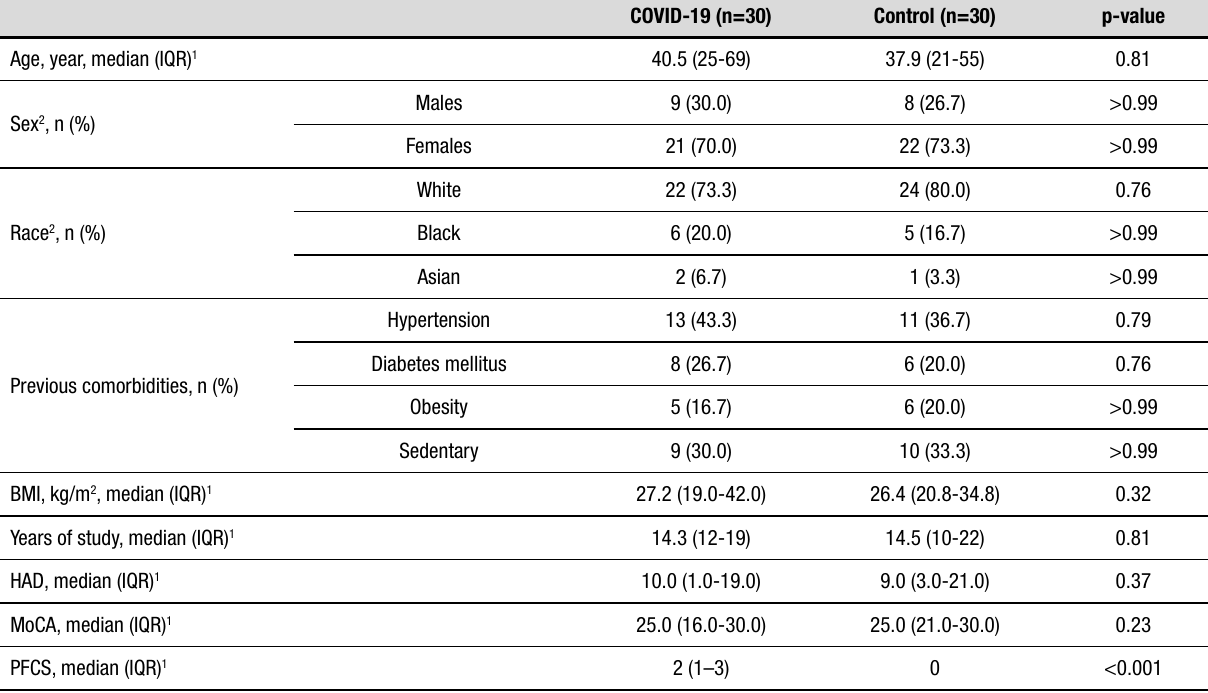
Table 1. Clinical and demographic profile of both